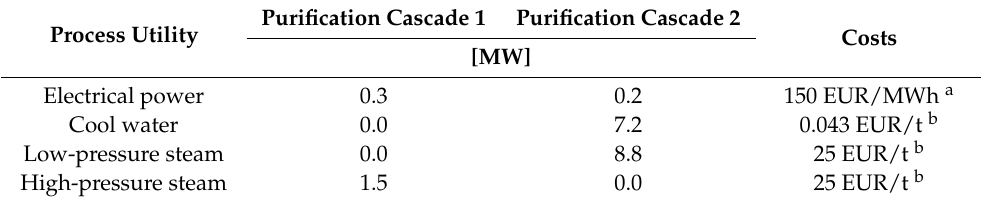
Table 5. Energy/utility requirements and costs of purification cascades 1 and